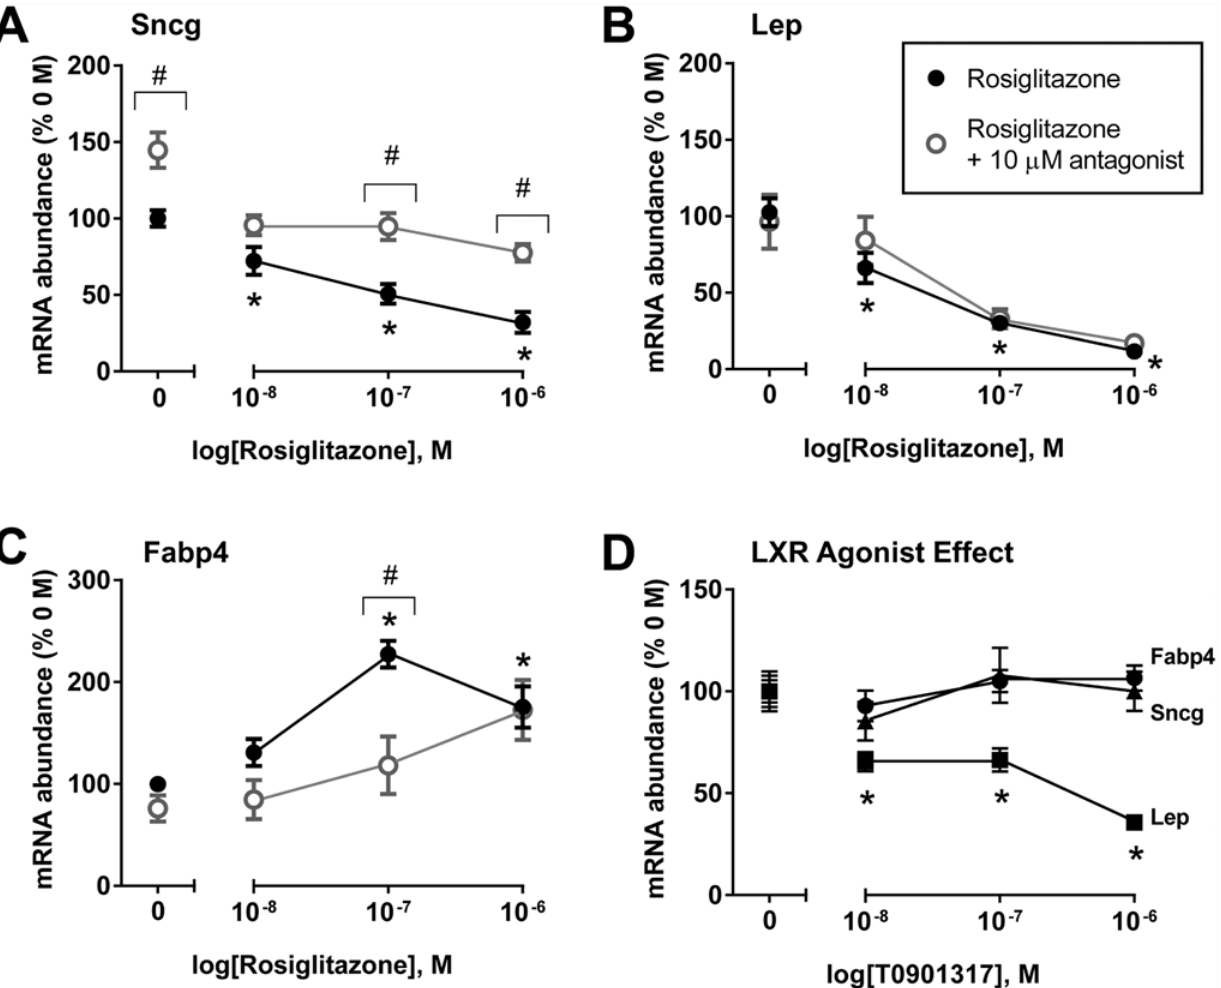
Fig 1. Regulation of mRNA expression levels for synuclein- γ (Sncg) (A), leptin (Lep) (B), and fatty acid binding protein (Fabp4) (C) by 24 hr short term treatment with the PPAR γ agonist rosiglitazone, or co-treatment with PPAR γ antagonist, T0070907, in mature 3T3-L1 adipocytes. Also shown are mRNA expression levels following treatment with LXR agonist, T0901317, in mature 3T3-L1 adipocytes (D) . Values are means +/- SEM, n = 7 – 15 per concentration; data from two experiments. Transcript level in vehicle-treated (0 M) control cells was considered 100%; gene expression values were calculated within experiment relative to control. * P < 0.05, 1-way ANOVA with a post hoc Dunnett ’ s test comparing rosiglitazone concentrations to the vehicle- treated control. #P < 0.05, Student ’ s t test for effect of 10 μ M T0070907 antagonist at each individual concentration of rosiglitazone. Raw data is provided in S1